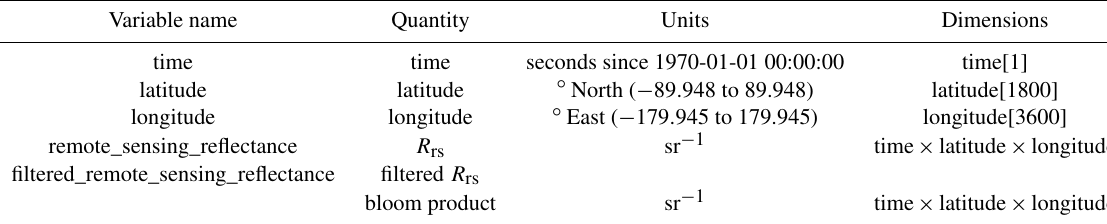
Table 2. Fields present in the available